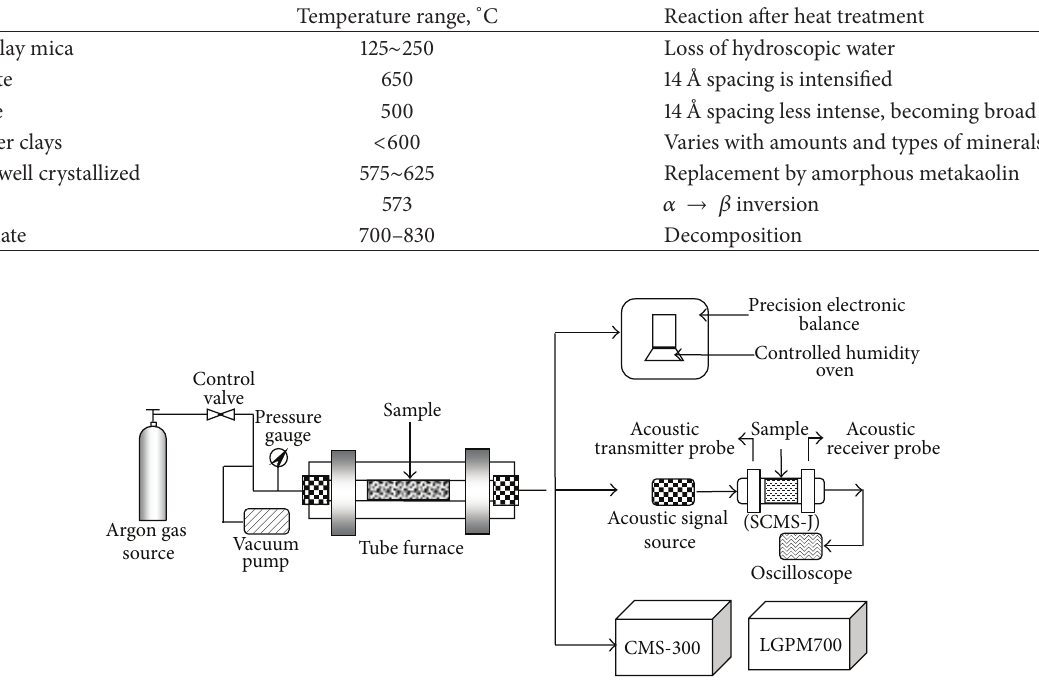
Figure 1: Schematic diagram of the experimental